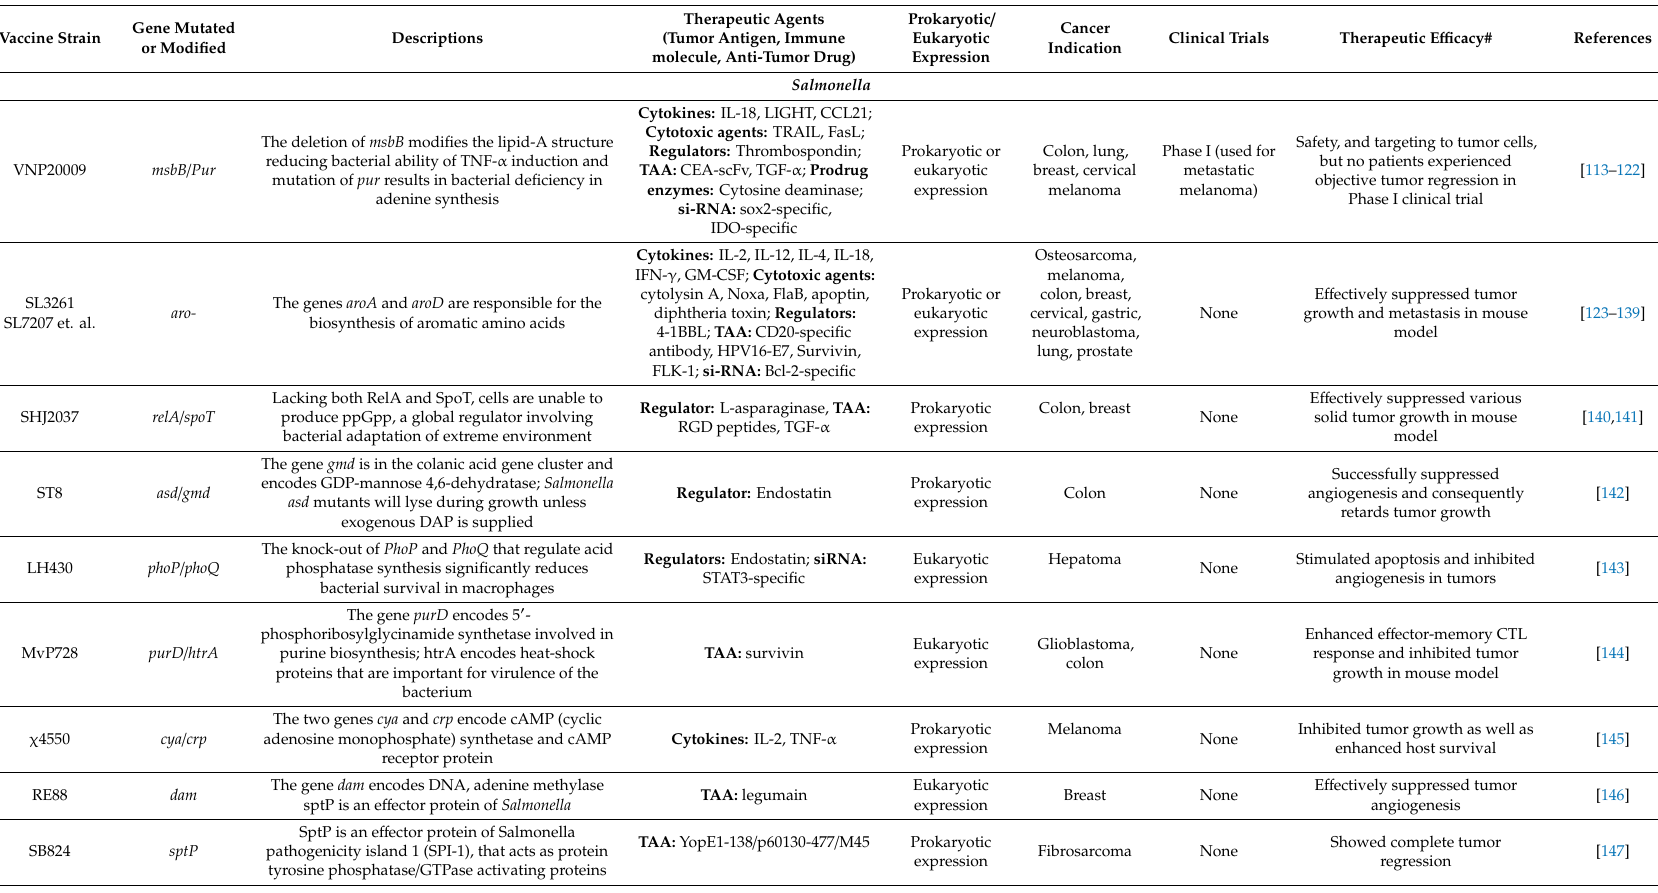
Table 2. Major live bacterial vectors used for cancer treatment and showing the potential of OMV- or extracellular vesicle (EV)-based cancer vaccines. Vaccine